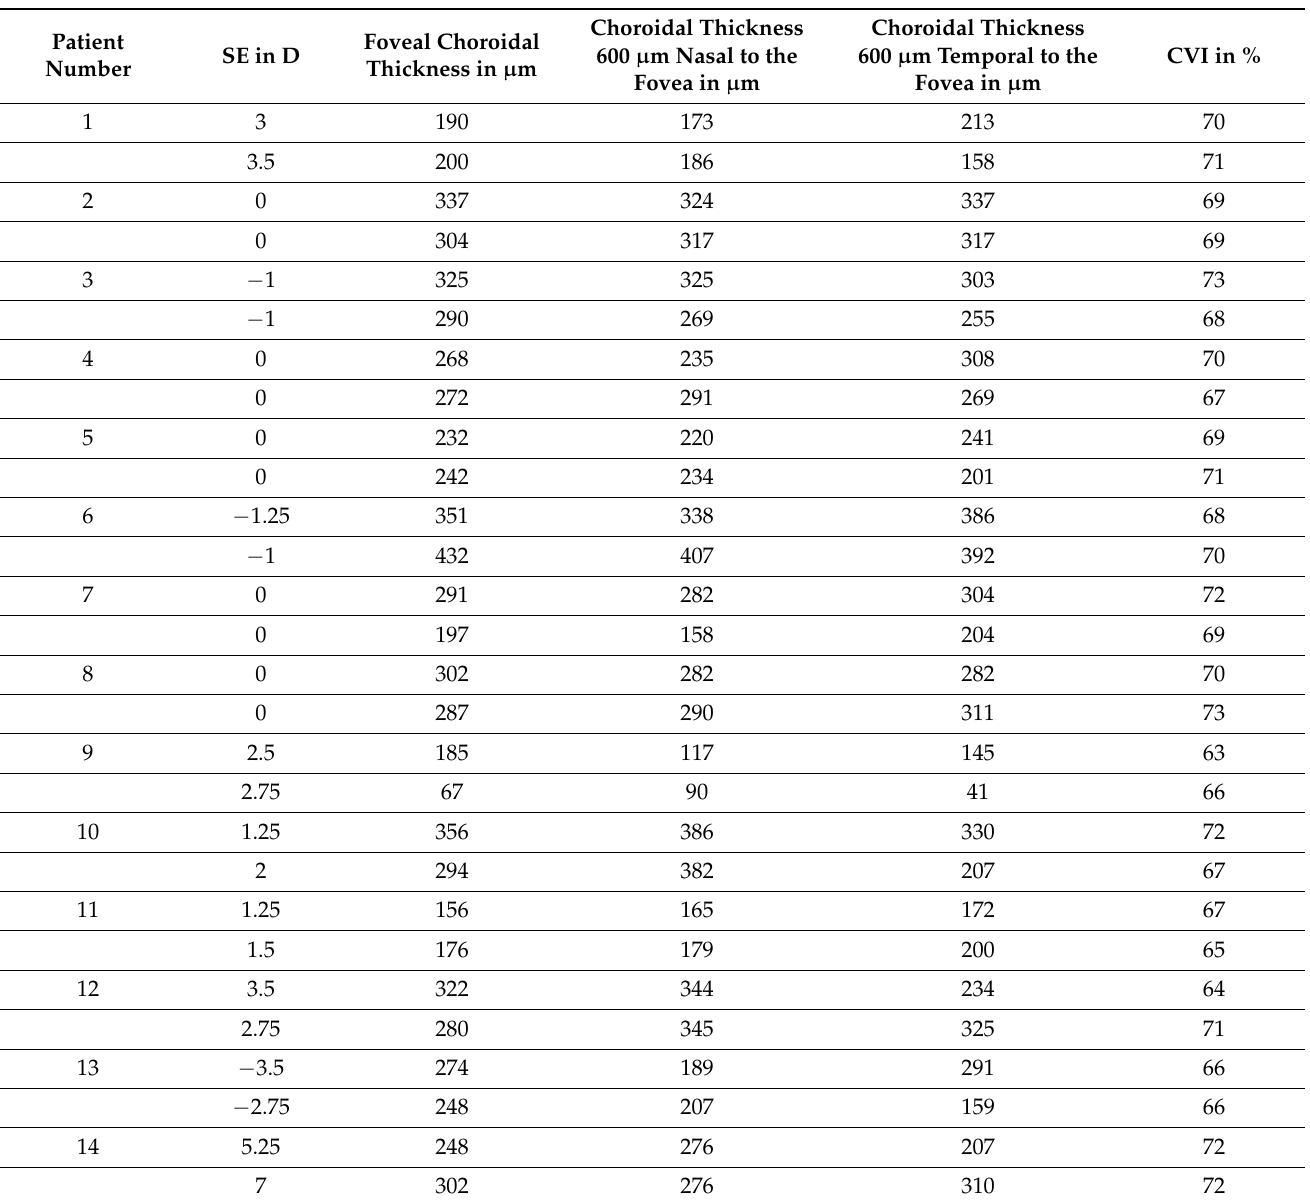
Table 4. Choroidal thickness in relation to spherical equivalence (SE) of each included patient. CVI: choroidal vascularity index; D: